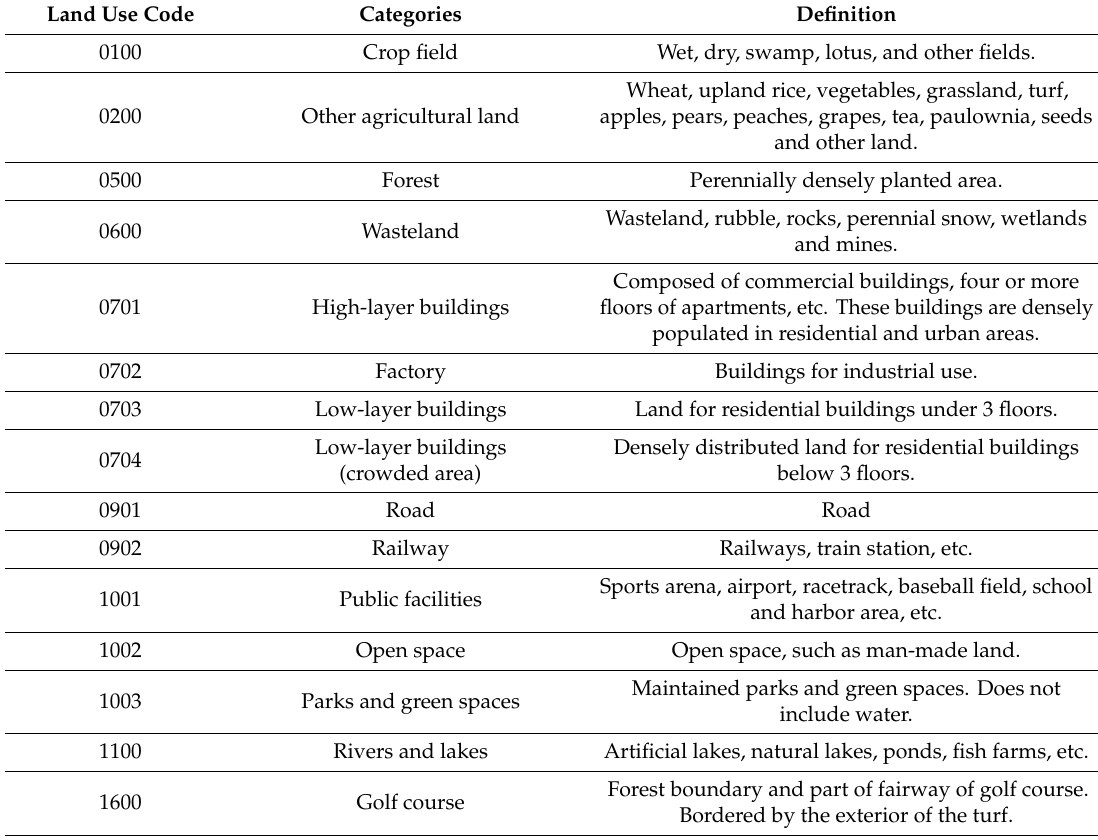
Figure 2. Land use map of Kyoto City. Table 1. Categories and definition of land use data.